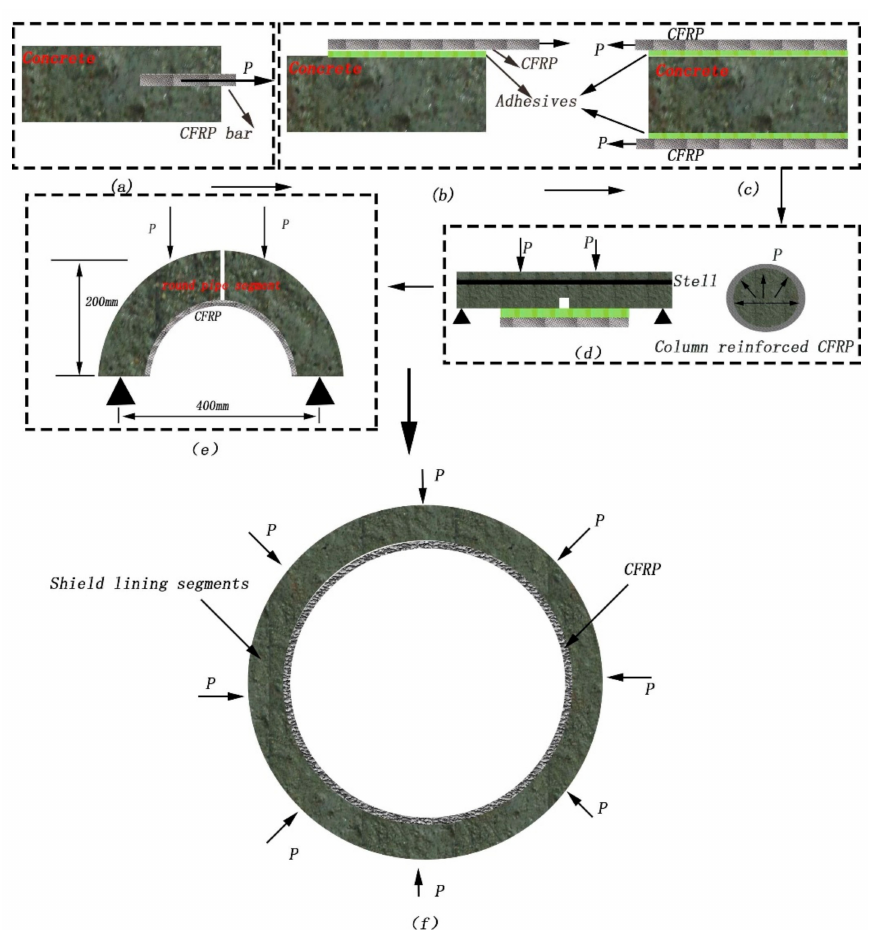
Figure 1. Design of problem statement. ( a ) Embedded methods, ( b ) single-shear method, ( c ) double- shear method, ( d ) reinforced notched beam, ( e ) bending and shear test, ( f ) stress model of this